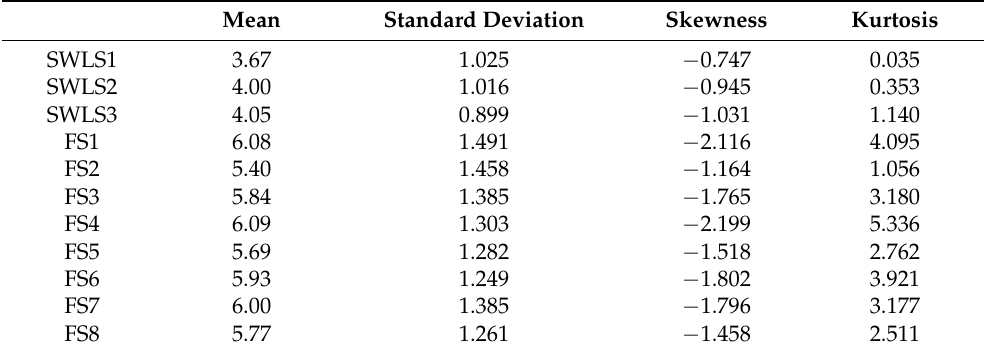
Table 1. Descriptive statistics for the items of the 3-item version of the Satisfaction with Life Scale (SWLS) and the Flourishing Scale (FS).